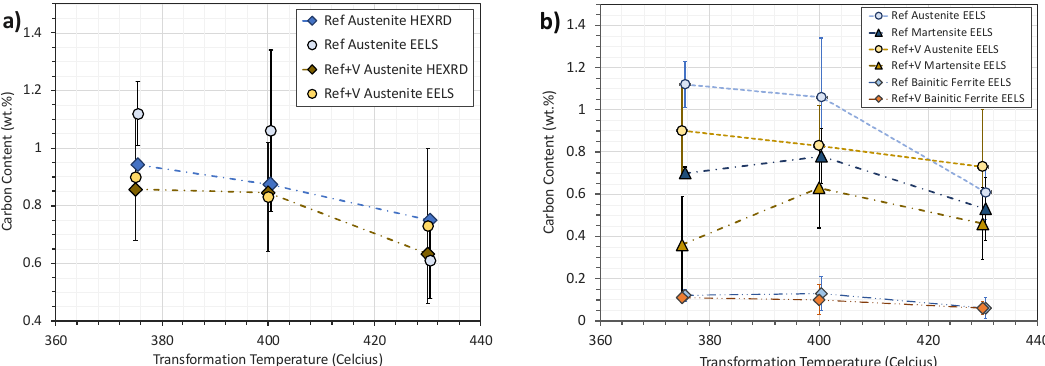
Figure 10. ( a ) Comparison of HEXRD and electron energy loss spectroscopy (EELS) carbon contents in austenite and ( b ) EELS carbon contents of austenite, martensite and bainitic ferrite. The error in the HEXRD carbon measurements is ± 0.011 wt. % The error bars in the EELS data show the standard deviation in the range of the measured values. Table 5. Final carbon contents in austenite, martensite and bainitic ferrite.